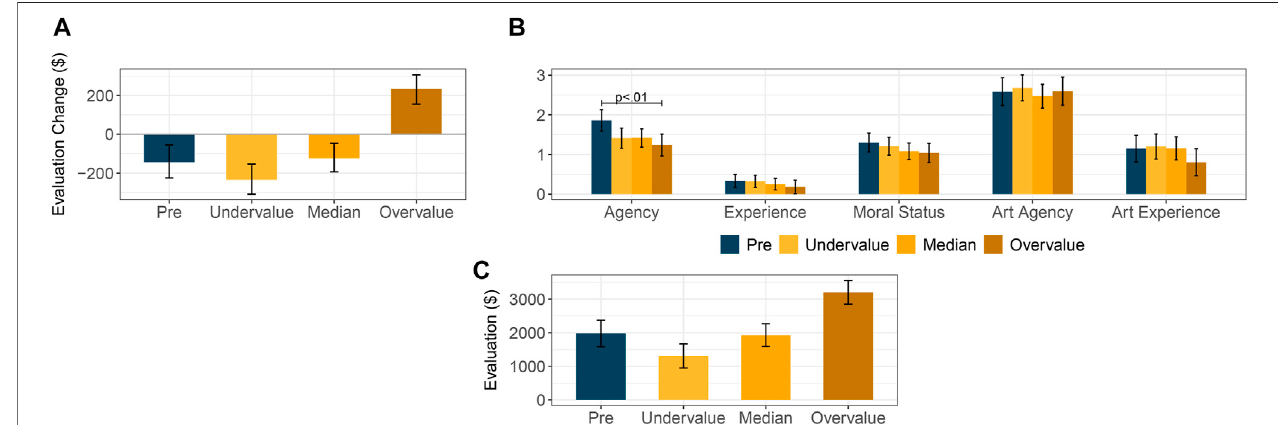
FIGURE 3 | To what extent participants modi fi ed their initial art evaluation after treatment in Study 2 (A) . Attributions of agency, experience, moral status, art agency, and art experience to the AI system depending on the condition participants were assigned to in Study 2 (B) . Marginal mean evaluation across all ten images depending on treatment group (C)